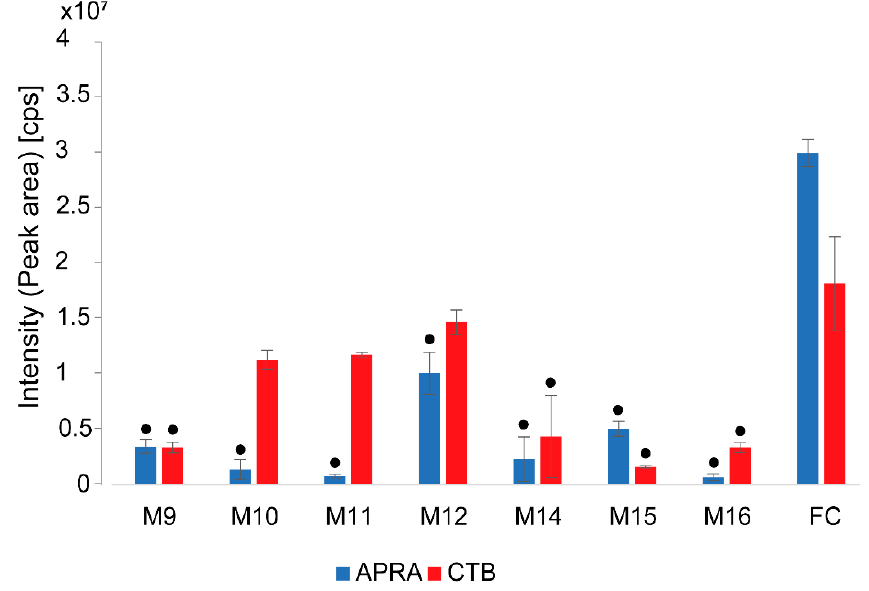
Figure 4. Production of apramycin (APRA) and carbamoyltobramycin (CTB) in Streptoalloteichus tenebrarius 2444 PS on different fermentation media: cps, counts per second (the number of ions that hit the detector per unit of time). The bars represent the means of triplicates (3 independent biological replicates), and the error bars represent the standard deviation (SD). The hypotheses H0 and H1 as well as the p -values of the Student’s t -test are included in Supplementary Materials Table S8. The results with p -values < 0.05 (production in each medium compared with the production in the FC medium) are marked with a black dot.